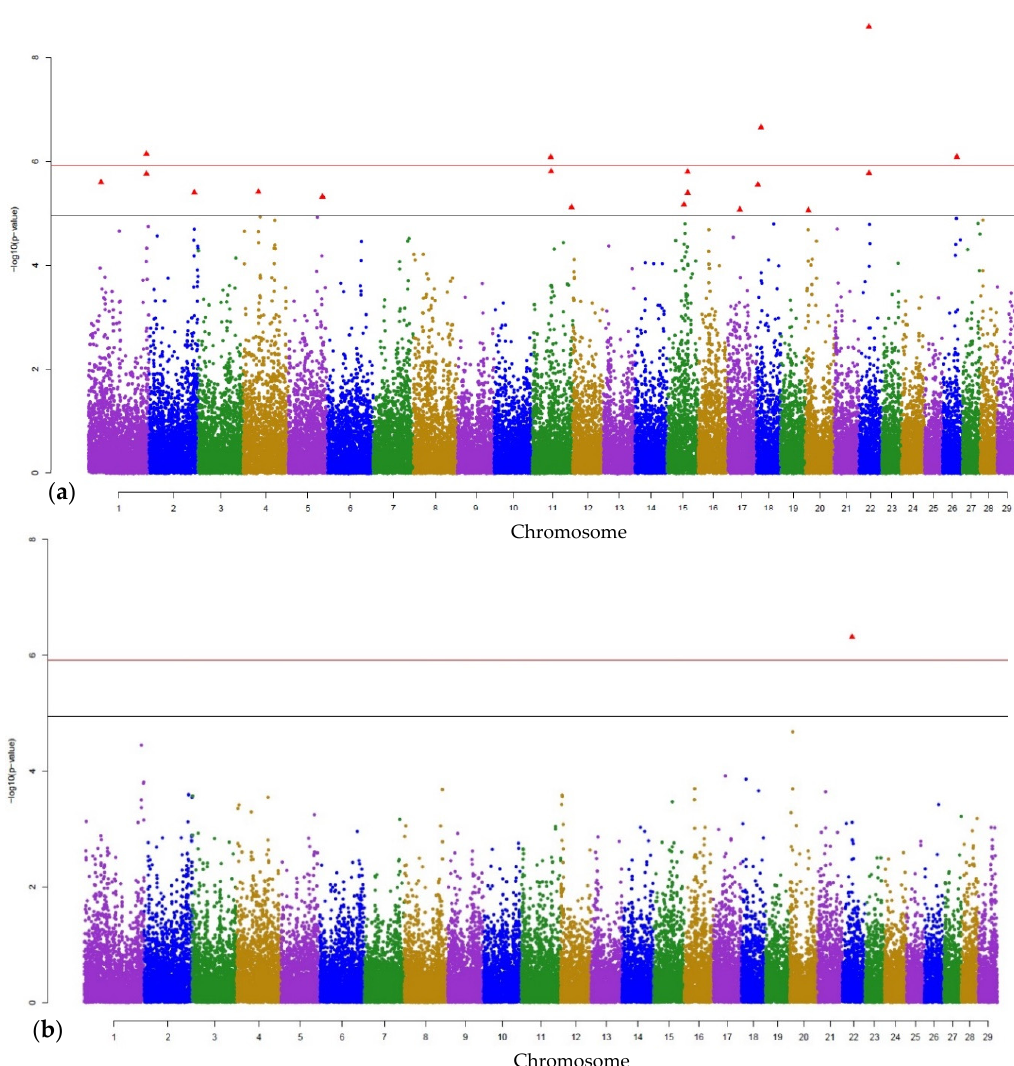
Figure 2. Manhattan plots displaying the GWAS results ( p -values) for MAJOR pathogens ( Aerococcus sp. , Aesculin hydrolyzing streptococci , Candida krusei , Enterococcus sp. , Escherichia Coli , Lactococcus sp. , Staphylococcus aureus , Streptococcus dysgalactiae , Streptococcus uberis , mold fungus , and Proteus sp. ): ( a ) indicates the main SNP effect, and ( b ) the interaction effect between SNPs and housing system. The Bonferroni-corrected genome-wide significance (red line) and the less conservative threshold (grey line) ( p sugg = 0.05/4479 = 1.12 × 10 − 5 ) are shown. Red triangles highlight the significant SNP.